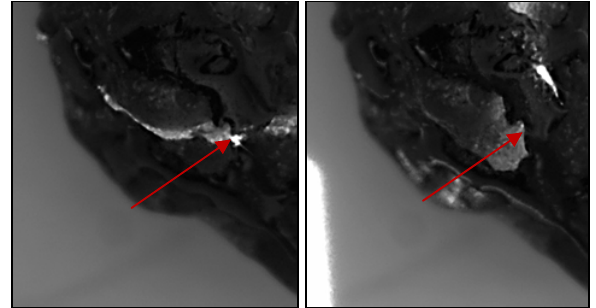
Figure 6: Detection of bright spots with different lightning directions (laser line). Left: longitudianal. Right: lateral.